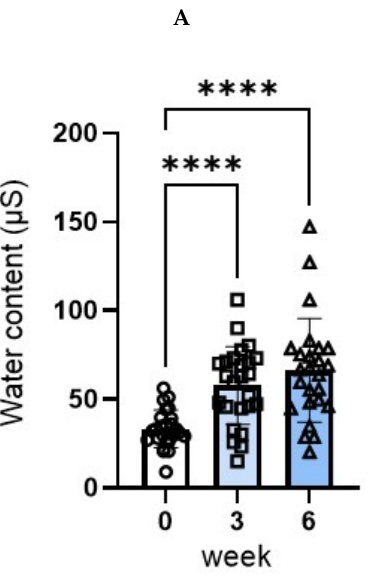
Figure 9. Effects of the POLG nano-emulsion on water content and TEWL. ( A ): Water content: n = 25, all data were analyzed using Tukey’s multiple comparison test and are expressed as means ± SD. ( B ): Barrier function: n = 25, all data were analyzed using Dunn’s multiple comparison test and are expressed as means ± SD. **: p < 0.01, ****: p < 0.0001 compared to week 0.